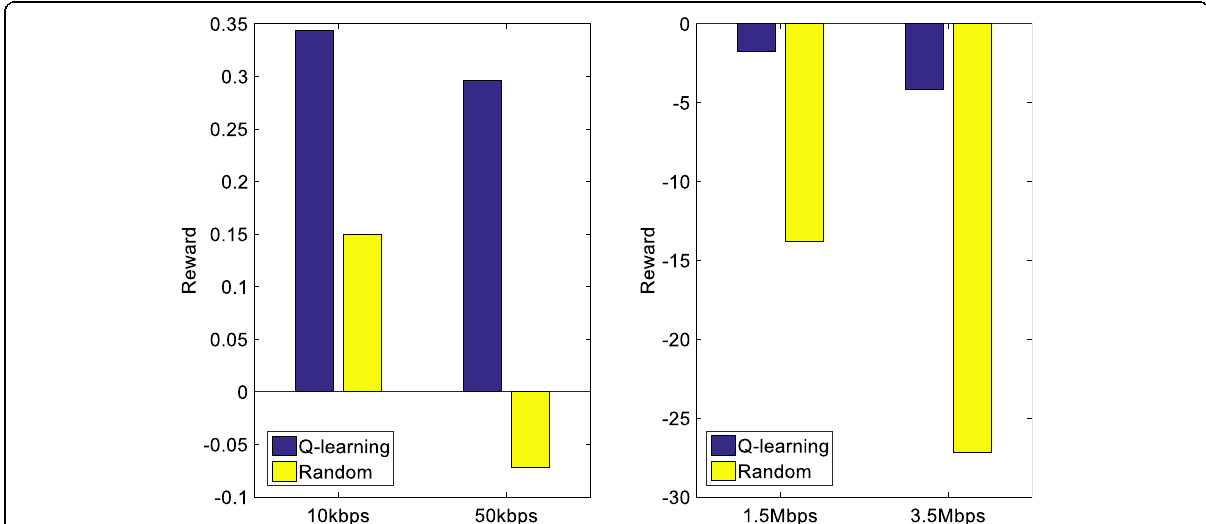
Fig. 18 Average reward comparison for Q-learning channel selection vs. random channel selection. The average reward for each DDR depending on the method of the channel selection. For all of the DDR cases, Q-learning band and channel selection has more reward value than random selection. The reward for a DDR of 1.5 or 3.5 Mbps (e.g., more than medium or high DDR case) is lower than that of 10 and 50 kbps. The ε -greedy policy in case of a high DDR causes very low reward for channel utilization R Util due to the selection of a low-band channel which support insufficient data rate and these effects are accumulated in the